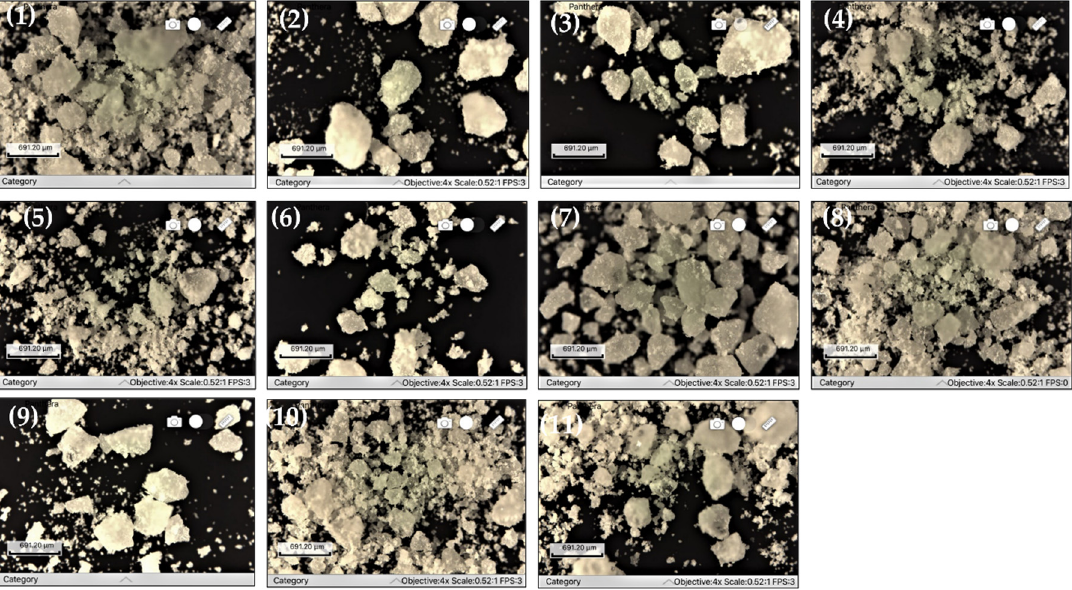
Figure 3. SDs micrographs ( 1 ) SD1; ( 2 ) SD2; ( 3 ) SD3; ( 4 ) SD4; ( 5 ) SD5; ( 6 ) SD6; ( 7 ) SD7; ( 8 ) SD8; ( 9